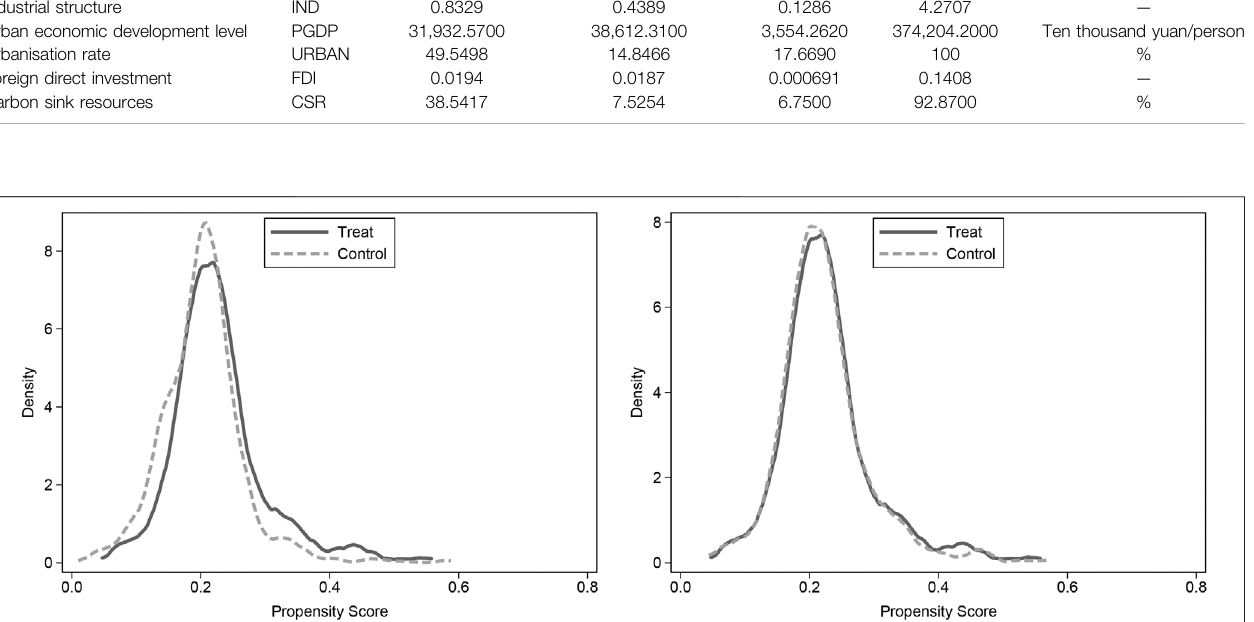
FIGURE 1 | Kernel density distribution comparison of propensity score values before and after kernel matching.